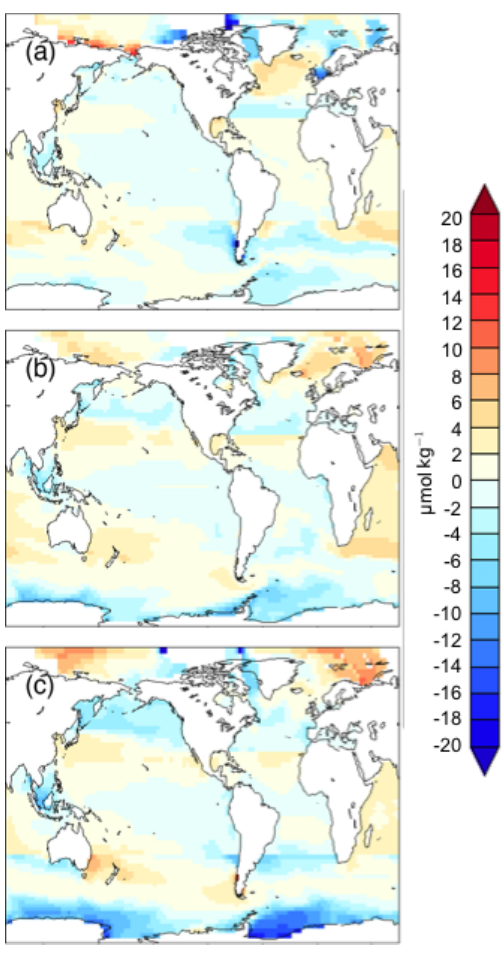
Figure A1. Shown is the difference between the exact DIC dis sur- face field in µmolkg − 1 , where DIC sat has been calculated using the surface alkalinity (alk [ z = 0 ] = alk pre [ z = 0 ] ) and DIC soft [ z = 0 ] = DIC carb [ z = 0 ] = 0. Differences are shown for (a) cold world; (b) moderate world; (c) hot